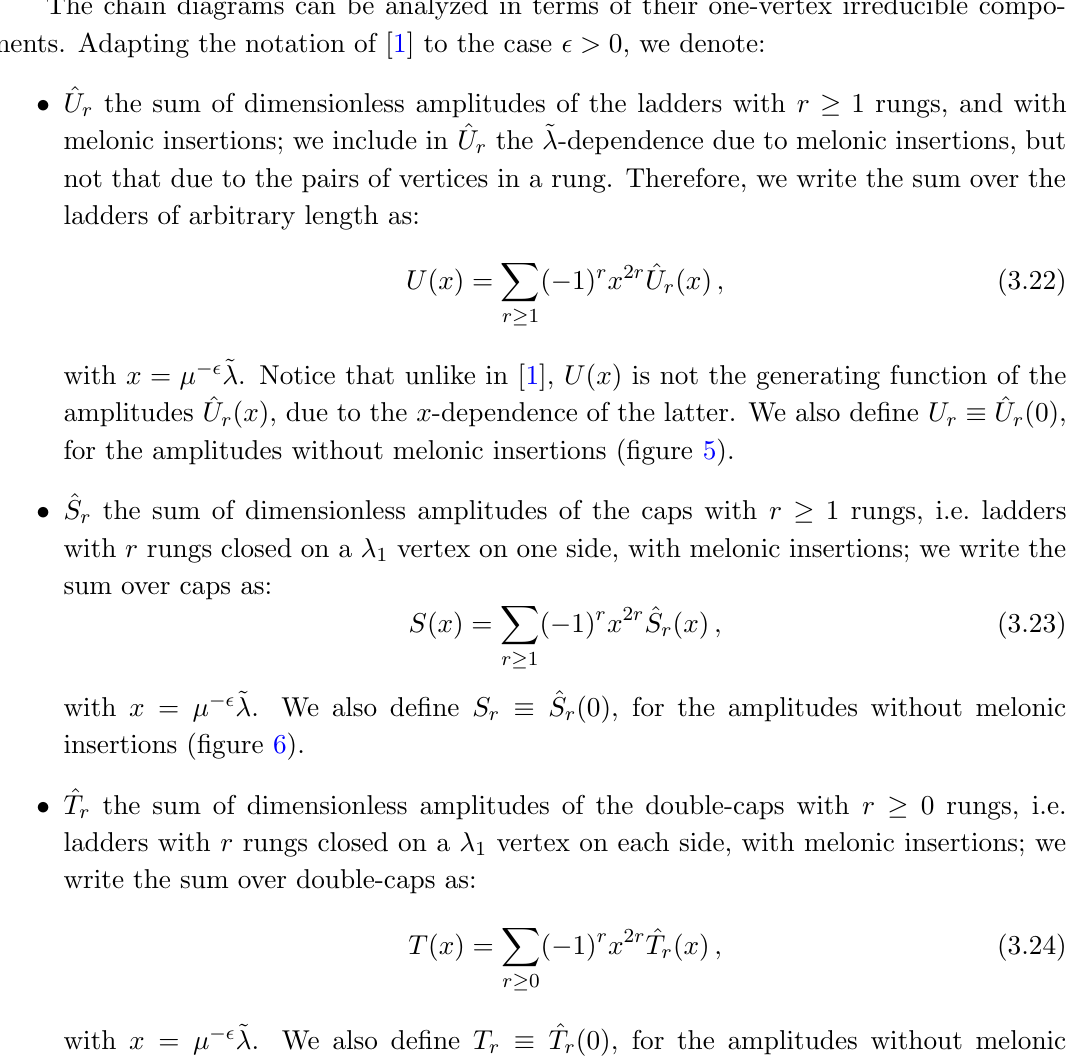
Figure 6 . The caps S 1 , S 2 , and S 3 . The blue vertex represents (cid:21) 1